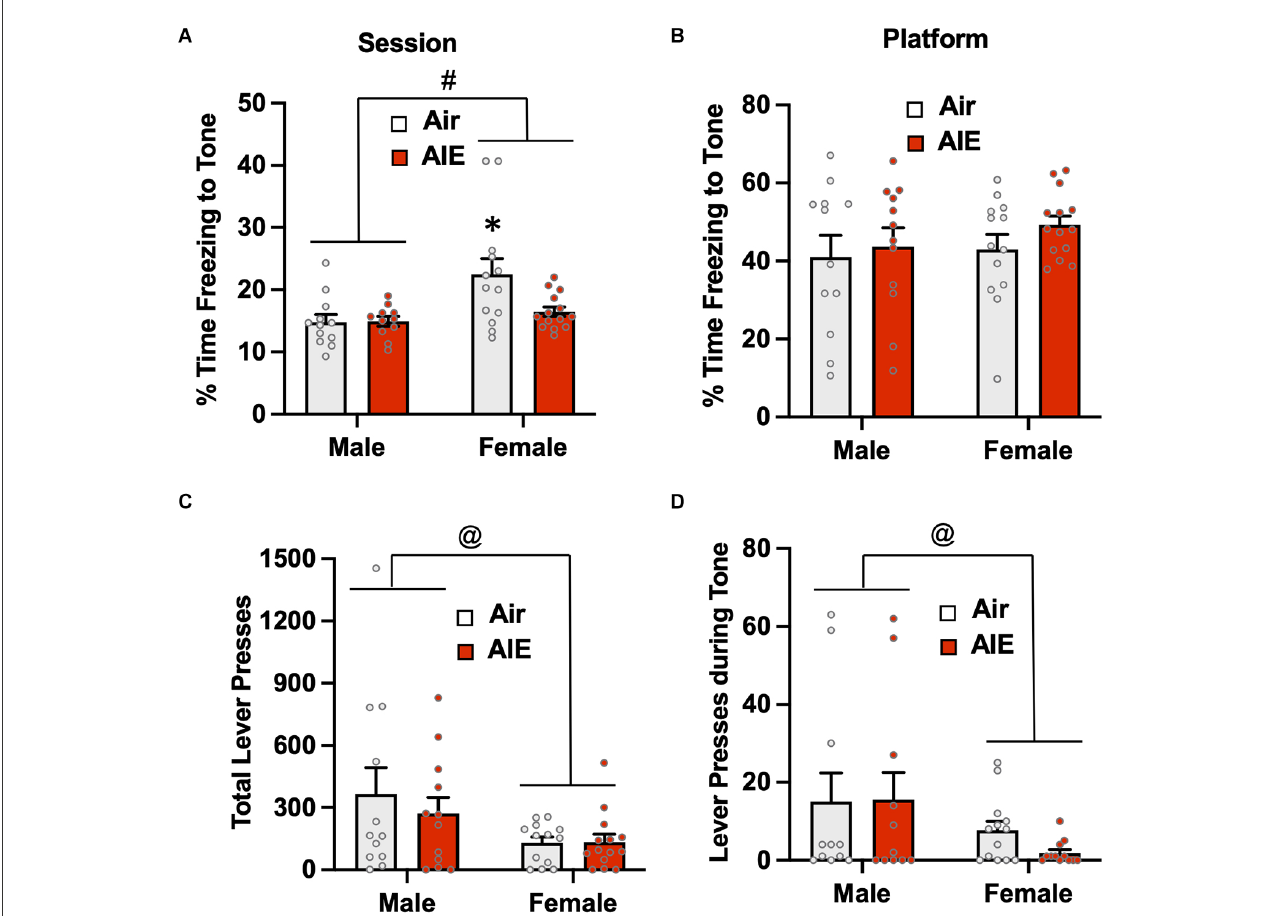
FIGURE5 Freezing behavior and lever pressing assessed on the first day of extinction of the platform-mediated avoidance task. (A) When freezing during tone presentation on the first day of extinction was examined irrespective of the location, female rats exhibited higher levels of freezing compared to the males. A prior history of AIE exposure significantly reduced freezing to the tone in the female rats. (B) When analysis of freezing during tone presentation was restricted to when the rats were located on the platform, the sex difference and effect of AIE exposure on freezing was no longer observed. (C) Examination of total lever responding during the test session revealed lever pressing by female rats was significantly reduced compared to male rats. (D) The sex-specific reduction in lever pressing was also observed during presentation of the tone. Data represent the means ± sem ( n = 12–13/group). # indicates significant difference between males and females, p = 0.005; ∗ indicates significant difference from all other groups, all p values < 0.05; @ indicates significant differences between males vs. females, all p values <